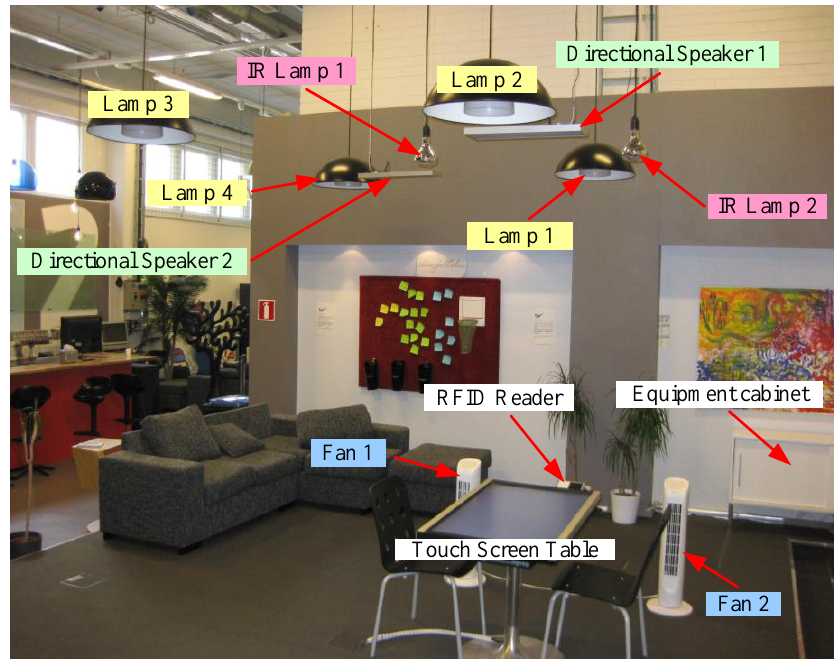
Touch Screen Table